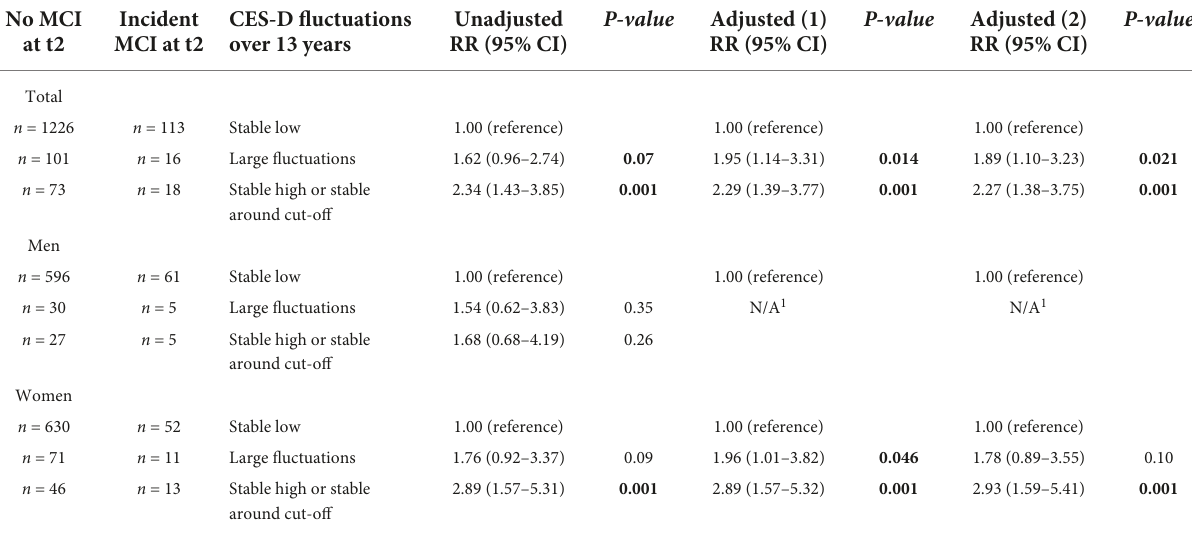
TABLE 3 Association between Center for Epidemiologic Studies Depression Scale (CES-D) fluctuations over 13 years and incident mild cognitive impairment (MCI) at t2 for the total sample and stratified by sex. Relative risk for incident MCI at t2 No MCI at